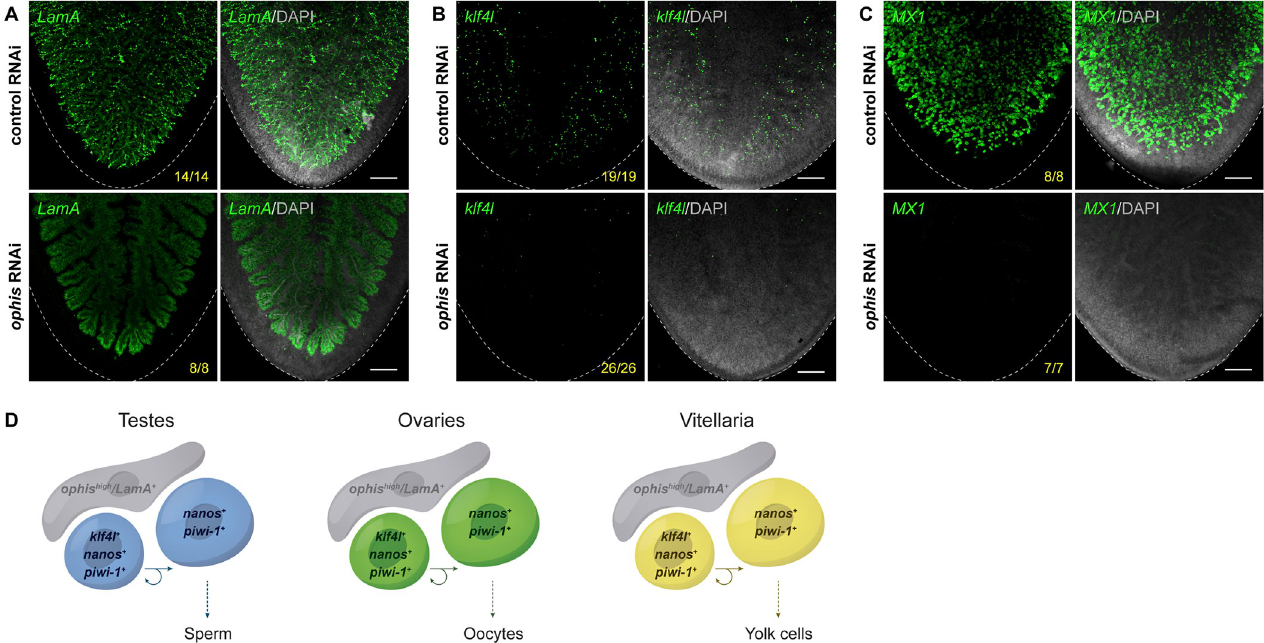
Fig 8. Germ cell niche factor ophis is required to sustain yolk cell production/vitellogenesis. ( A–C ) Maximum intensity projections of confocal sections showing FISH of LamA ( A ), klf4l ( B ), and MX1 ( C ) (green) in the ventral posterior region of sexually mature control versus ophis RNAi animals. Dashed line denotes planarian boundary. N = 3 to 5 experiments, n = 7 to 26 planarians. ( A ) ophis RNAi results in a dramatic loss of the LamA + cells throughout the vitellaria. Note that LamA expression is only visible in the branched gut in ophis RNAi planarians. ( B , C ) ophis RNAi results in a reduction of klf4l + yolk cell progenitors and MX1 + differentiated yolk cells. ( A–C ) Nuclei are counterstained with DAPI (gray). Scale bars, 200 μ m. ( D ) Model depicting similarities shared between gonads (where gametogenesis occurs) and vitellaria (where yolk cell production occurs). klf4l + / nanos + / piwi-1 + presumptive GSCs in testes and ovaries divide and give rise to klf4l – / nanos + / piwi-1 + progeny. These germ cells are supported by ophis + somatic gonadal niche cells. Vitellaria are comprised of klf4l +